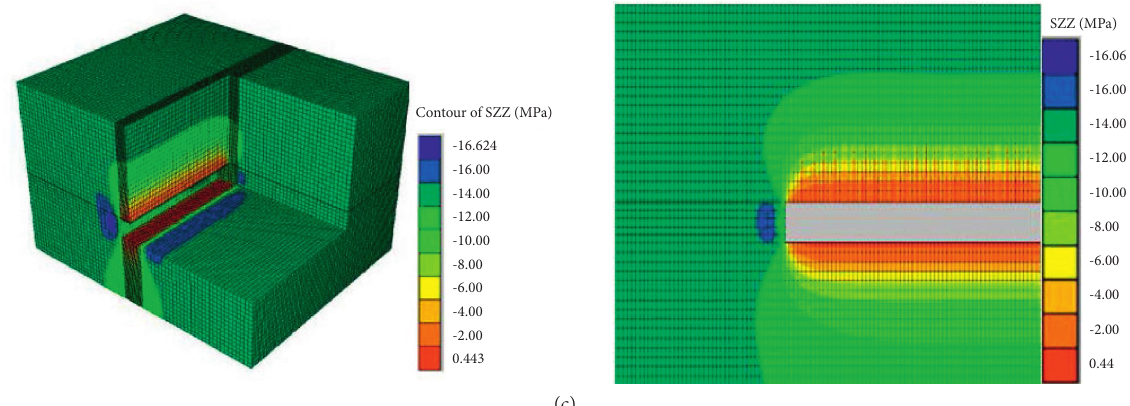
Figure 12: Vertical stress cloud diagram of surrounding rock of roadway under different unsupported roof distances: when the unsupported roof distances is (a) 1.0m, (b) 2.0m, and (c) 3.0m.